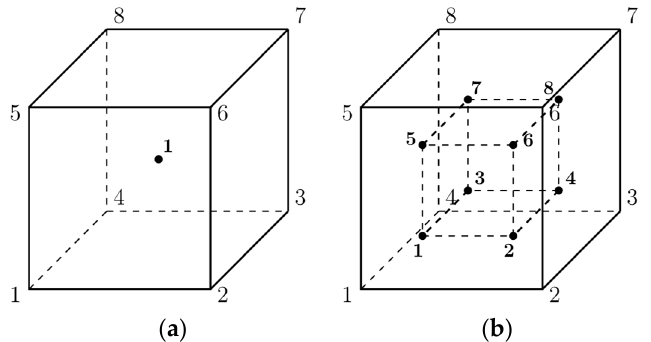
Figure 5. ( a ) C3D8R element with reduced integration (1 integration point) versus ( b ) C3D8 ele- ment (fully integrated—2 × 2 × 2 integration points) [30].